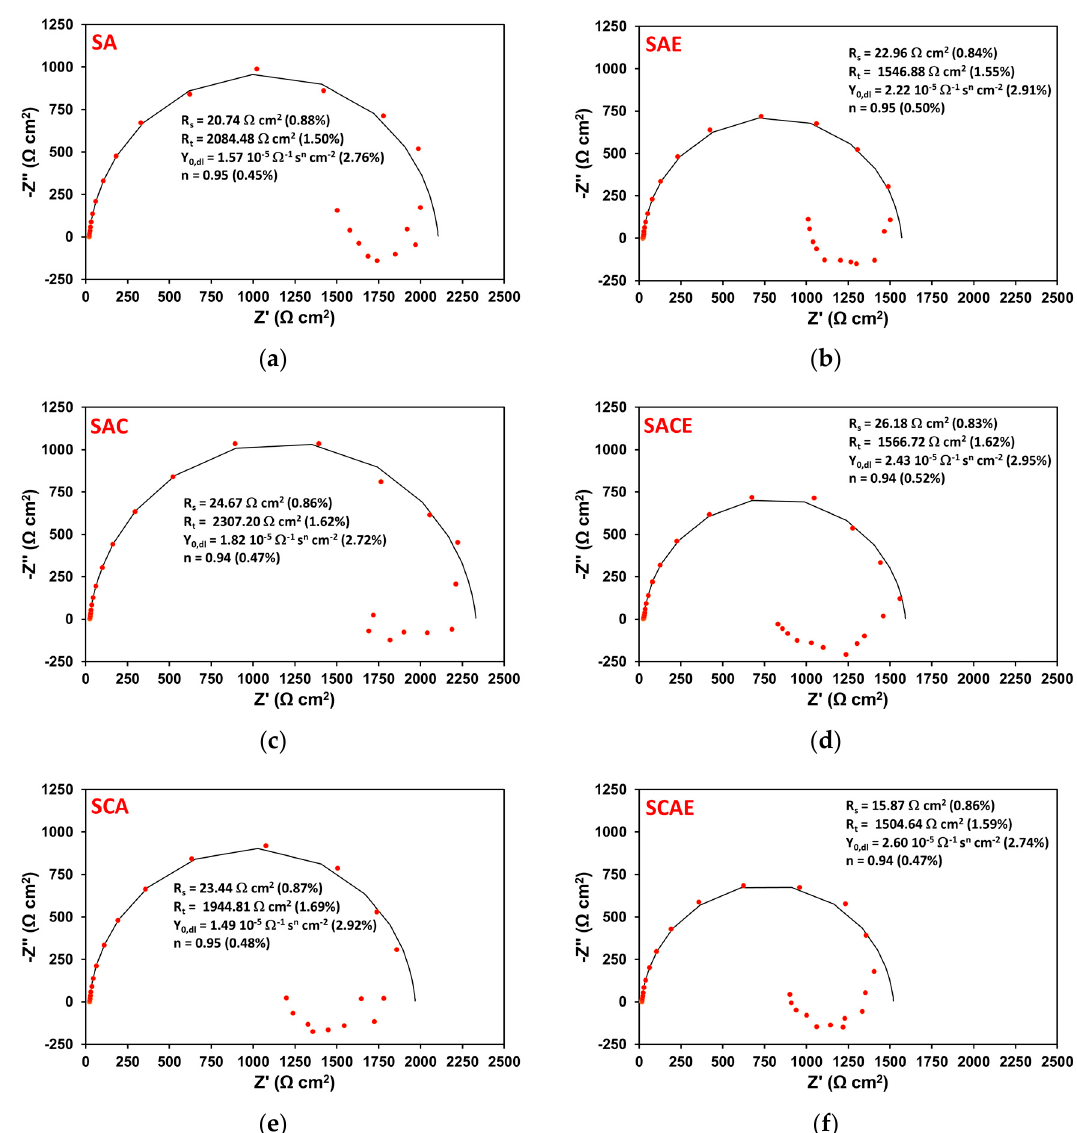
Figure 5. Nyquist plots obtained on a representative sample of the different series (Table 1) after 6 h of exposure in aerated solution: SA ( a ); SAE ( b ); SAC ( c ); SACE ( d ); SCA ( e ); SCAE ( f ). The red symbols represent the experimental data, while the solid black curves correspond to the results of the fitting explained in the text. On each plot, the fitting parameters are reported together with the relative values and percentage errors, put in brackets.